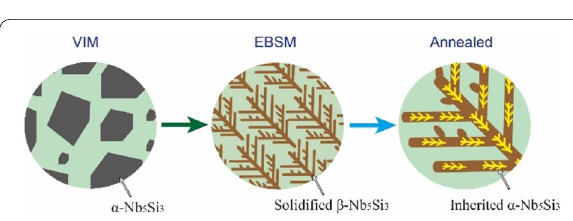
Figure 8 Schematic of morphology evolution of